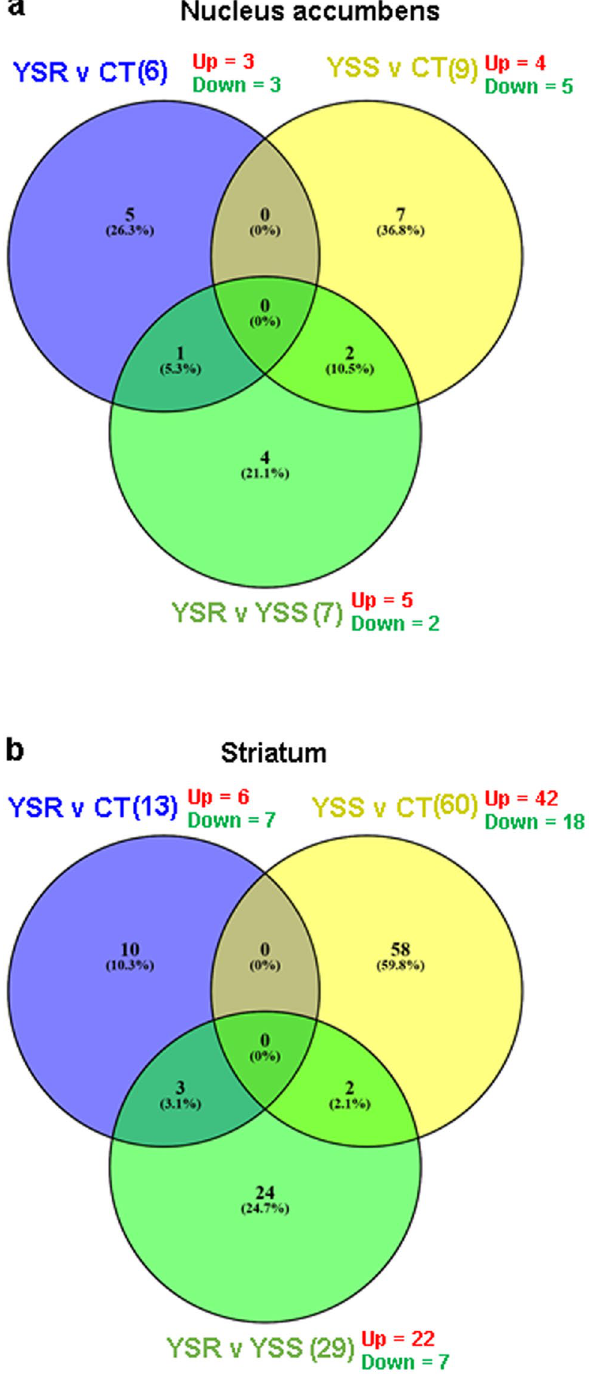
Figure 3. Microarray analysis of gene expression in the NAc and striatum of rats after one month of withdrawal from methamphetamine SA. Comparison of gene expression in pairwise comparisons between YSR (n = 3), YSS (n = 3), and control (n = 6) rats in NAc ( a ) in dorsal striatum ( b ). The number of up- and downregulated genes in each comparison is shown in red and green, respectively. The list of genes and their classification are shown in Tables 3 and